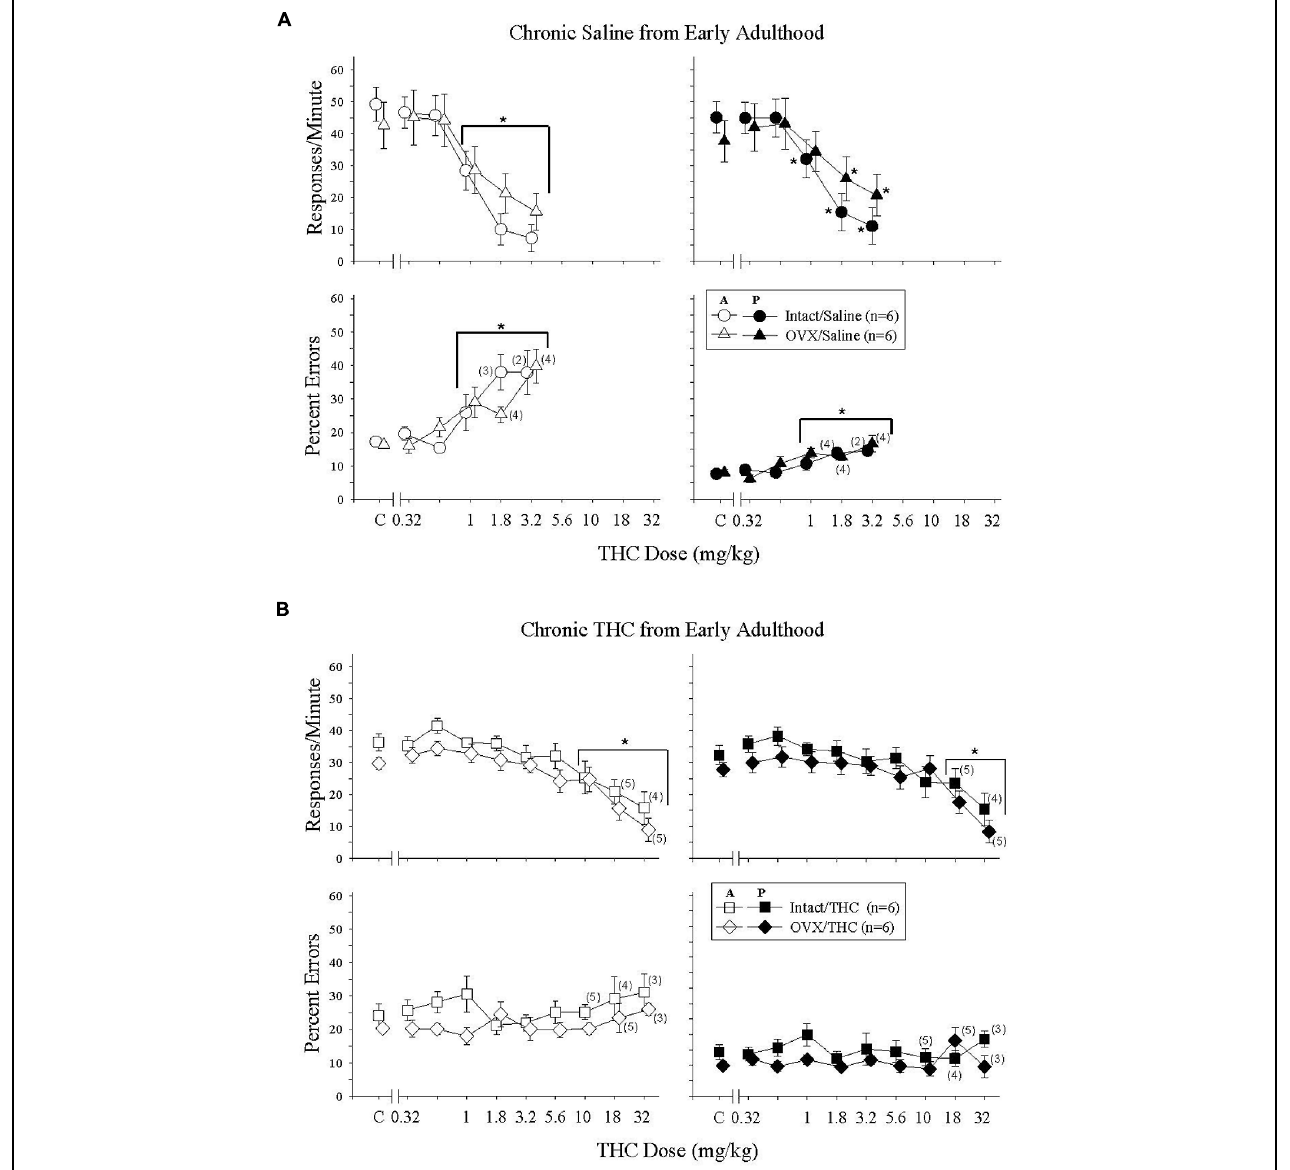
FIGURE 3 | Acute effects of (cid:2) 9 -THC in intact and OVX females that received either saline (A, upper four panels) or 5.6 mg/kg of (cid:2) 9 -THC (B, lower four panels) daily from early adulthood to sacrifice and that were responding under an acquisition (A, graph legend) and performance (P, graph legend) procedure. Data points and vertical lines above C in each panel indicate the grand mean and standard error of the mean (SEM) for 9–19 saline (control) injections. The data points and vertical lines in the dose-effect curves represent a grand mean and SEM for that dose, as each